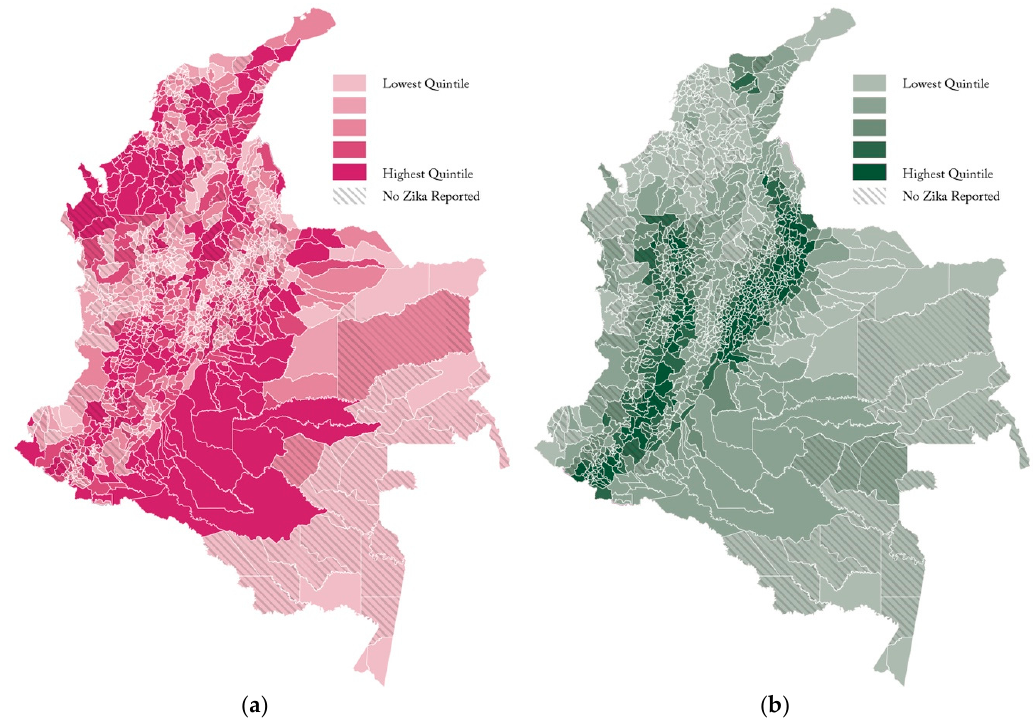
Figure 3. Municipality ‐ level cropland linear density measure ( a ), and average elevation ( b ).